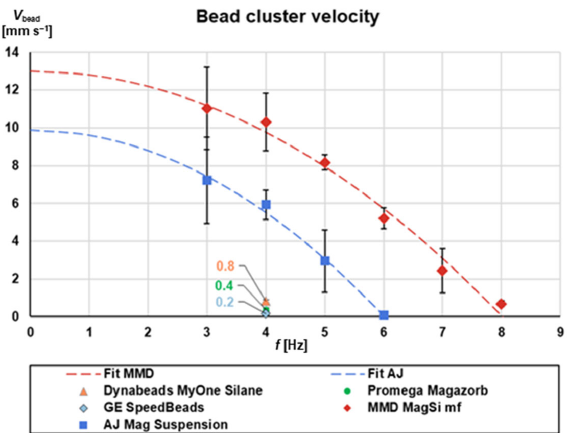
Figure 5. Bead cluster speed versus rotational frequency for different commercially available mag ‐ netic beads. AJ: Analytik Jena; MMD: MagnaMedics Diagnostics BV (currently magtivio BV); GE: GE Healthcare. The fit MMD and fit AJ gave R 2 = 0.9837 and R 2 = 0.9928, respectively ( n = 3; 1× standard deviation). Ferrimagnetic beads respond very strong to the magnetic field setup. We at ‐ tribute this to the clustering behavior of ferrimagnetic beads under an external magnetic field.